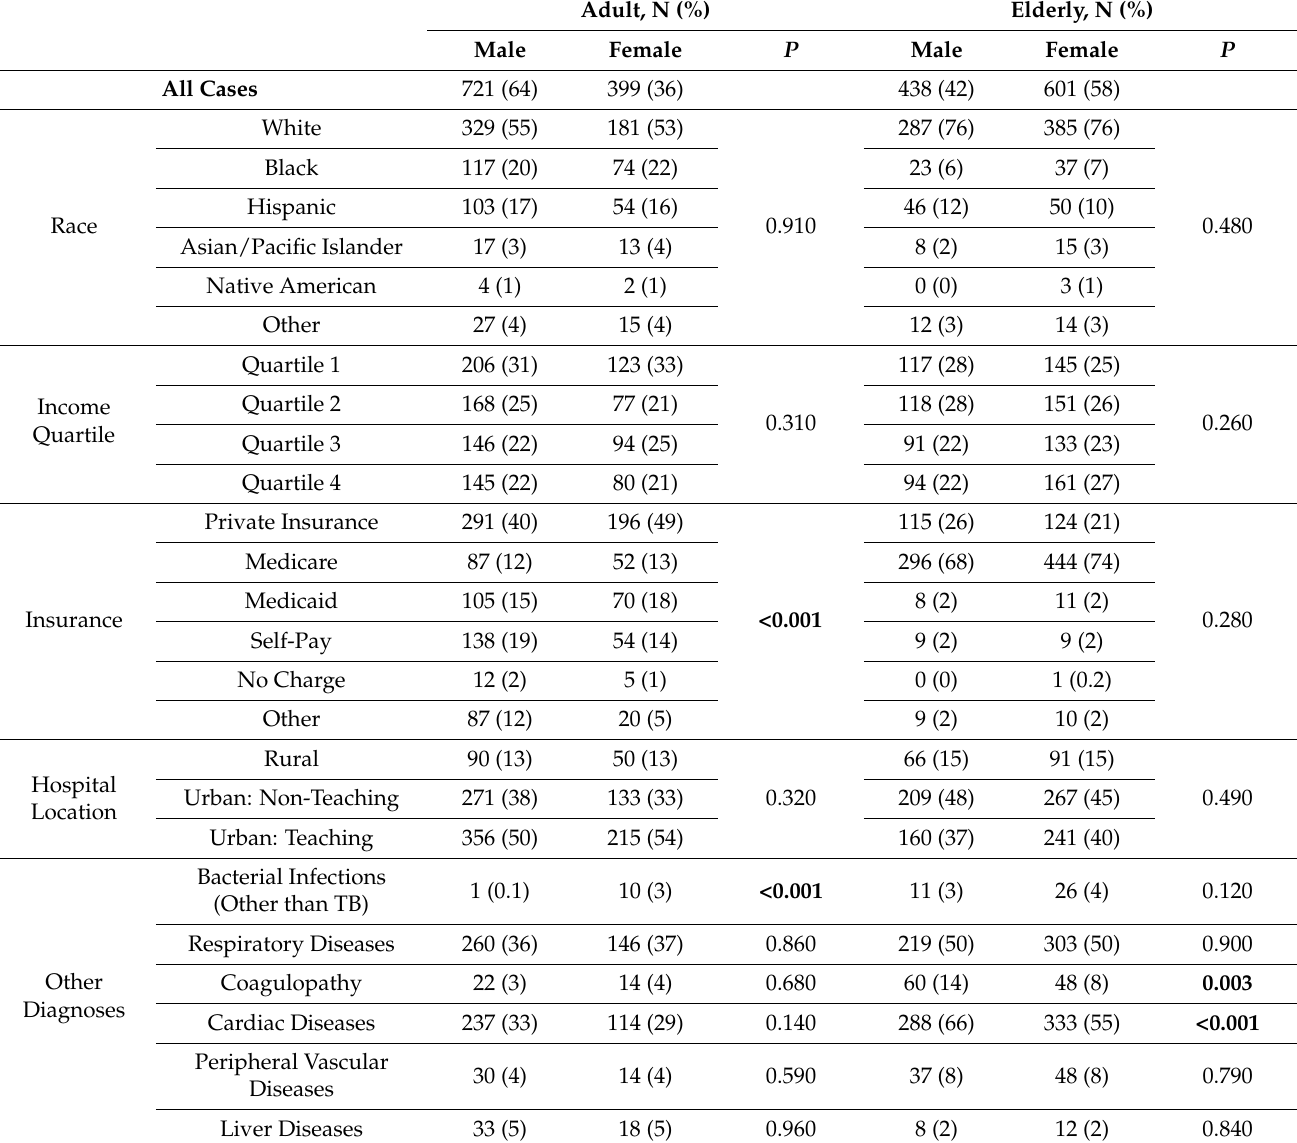
Table 1. Characteristics of emergently admitted patients with a primary diagnosis of blunt chest wall injury. Data are stratified according to sex categories, NIS 2004–2014. Adult, N (%) Elderly, N (%) Male Female P Male Female